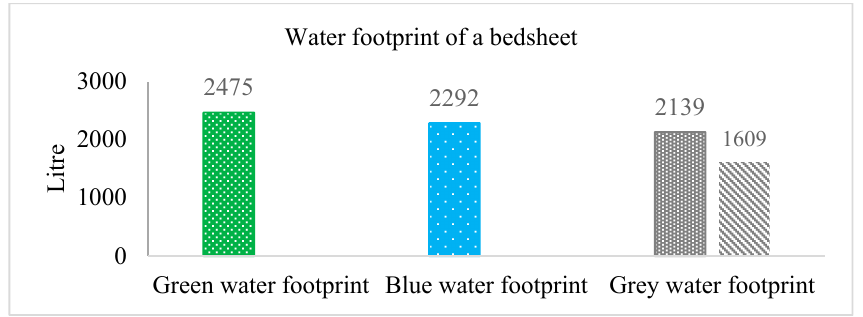
Figure 14. Water footprint of a single bedsheet; with and without having functional ETP and STP, the grey water footprint would be 1609 L and 2139 L.